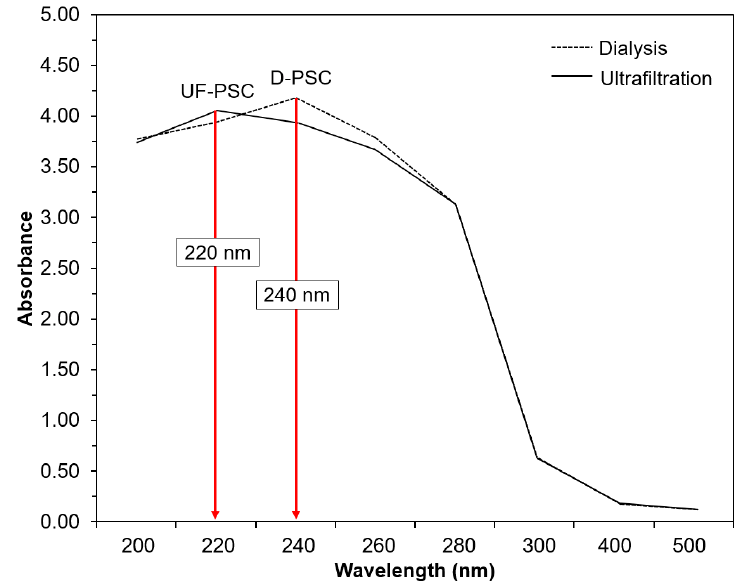
Figure 1. UV-Vis spectra of collagen from sea cucumber ( Holothuria scabra ) isolated through dialysis and the ultrafiltration membrane.